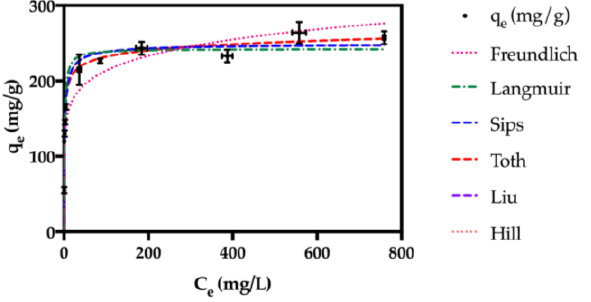
Figure 8. Isotherm data and corresponding model fitting for the adsorption of paraquat on the